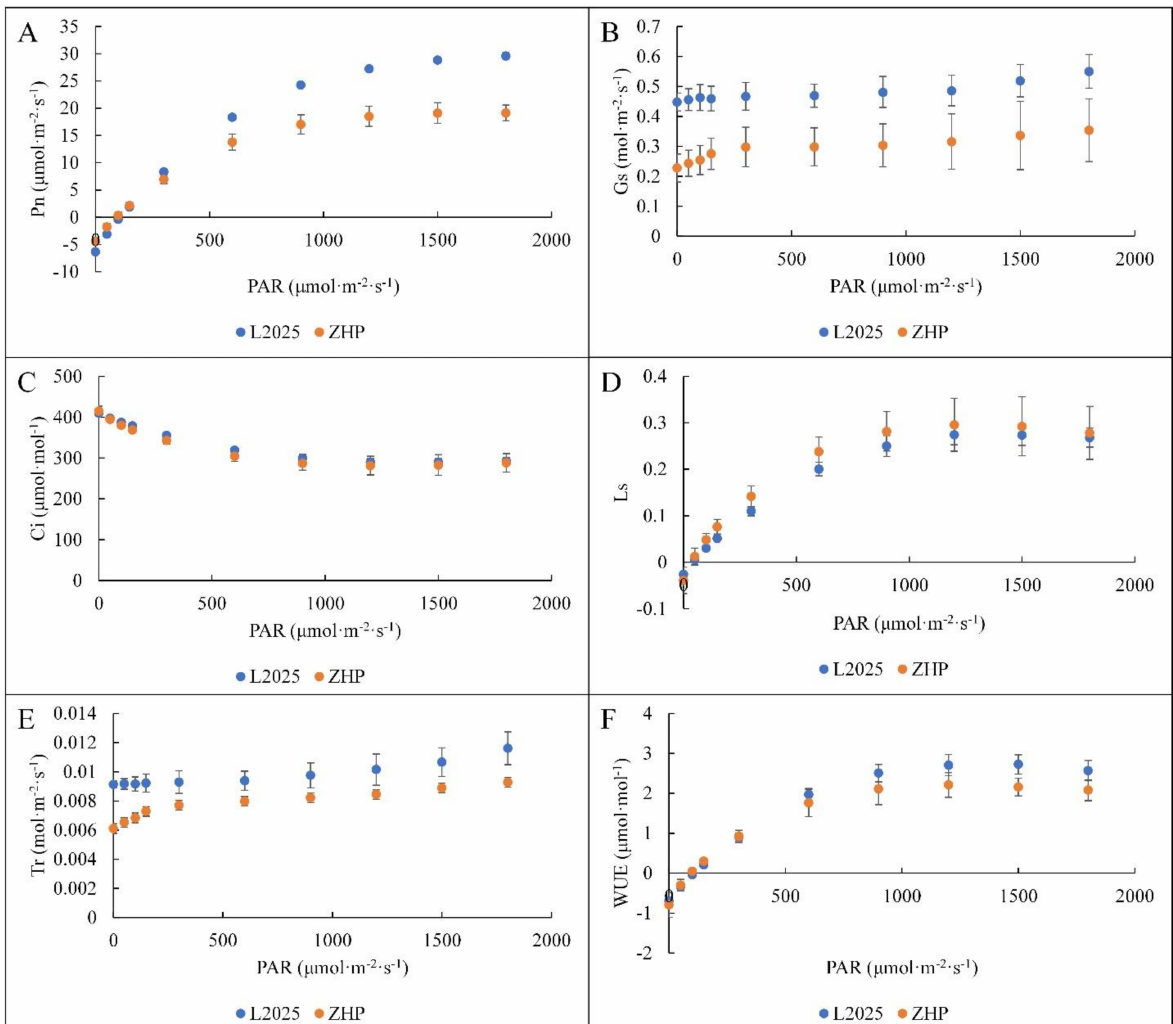
Figure 2. Changes in photosynthetically active radiation (PAR) responses from the leaves between ‘L2025’ and ‘ZHP’: ( A ) net photosynthetic rate (Pn). ( B ) stomatal conductance (Gs). ( C ) intercellular CO 2 concentration (Ci). ( D ) stomatal limitation (Ls). ( E ) transpiration rate (Tr). ( F ) water use efficiency (WUE). Data are means ± SE ( n =